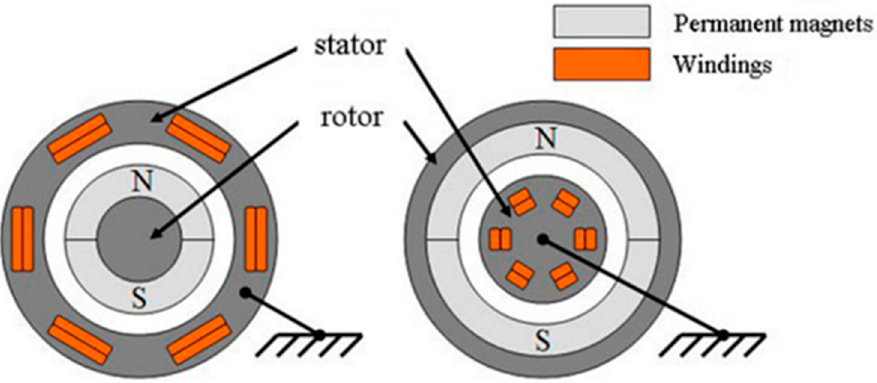
Figure 32. Structure of Permanent Magnet Synchronous Machine (PMSM).